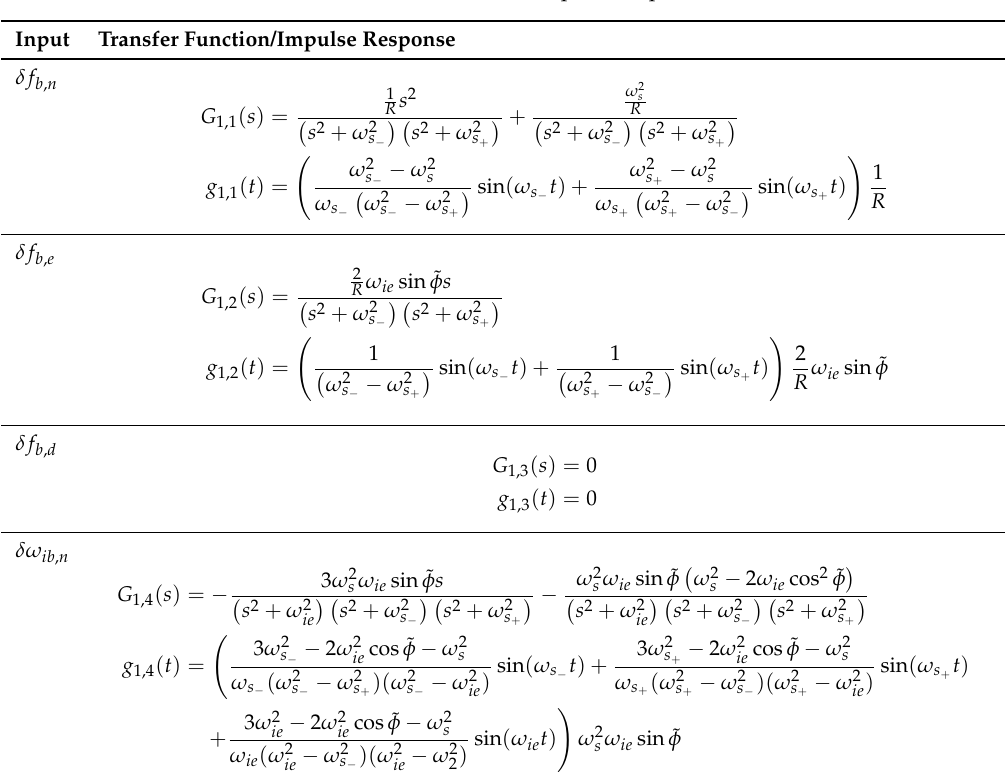
Table A1. Latitude error impulse